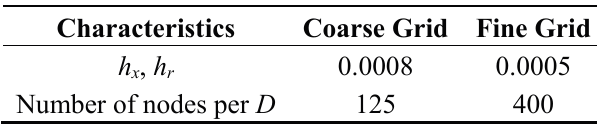
Table 1. Using difference